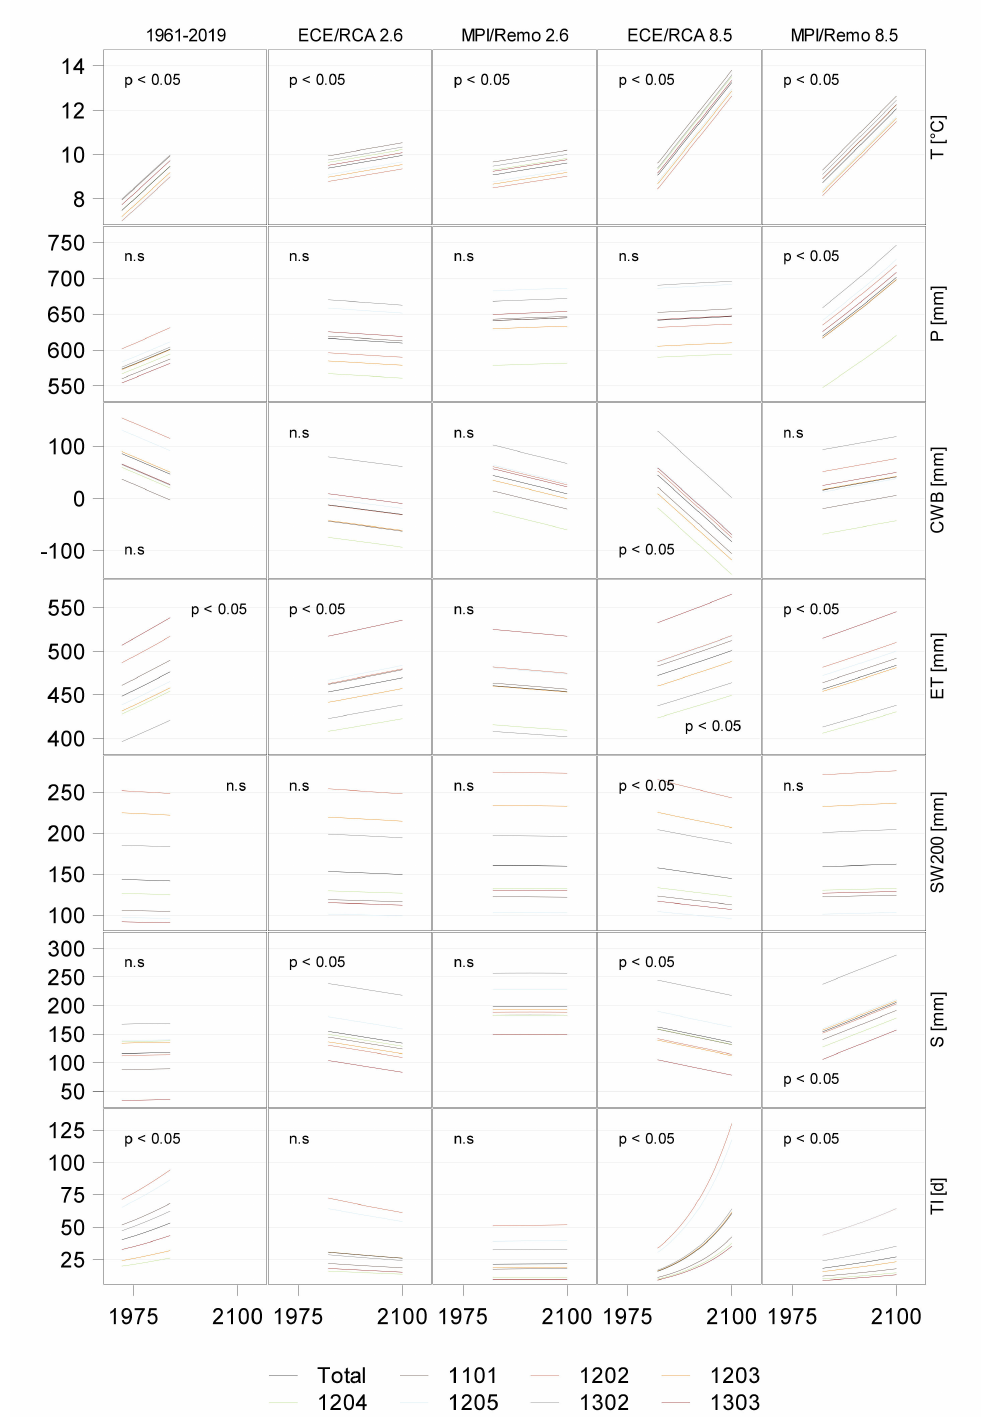
Figure 4. Temperature (T), precipitation (P), climate water balance (CWB), actual evapotranspiration (ET), plant-available soil water down to a depth of 2 m (SW), seepage (S), and dry days (TI) in 1961–2019 and under scenarios in 2010–2100, for individual plots and whole dataset (black). The significant slope of the whole dataset is denoted by p < 0.05, non-significance by